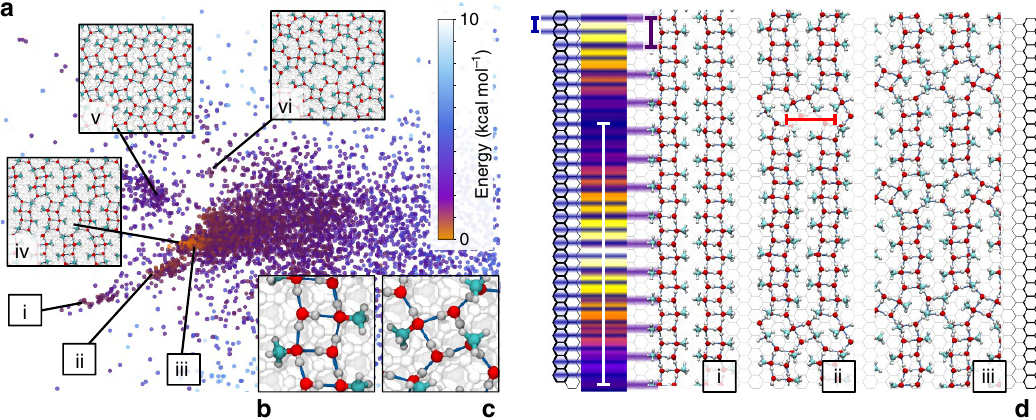
Figure 3 | Catalogue of stable 2D structures for a 1:1 MeOH:water monolayer. Each structure was obtained by replica-exchange simulations ( a ). Each dot represents a particular structure whose stability (energy) is colour-coded. Six representative structures (i–vi) are presented (in inset ( a ) and in ( d )). Most structures share a recurring water-MeOH ‘square’ motif ( b ) forming ribbons. The same motif exists with a corner-sharing arrangement ( c ), inducing defects in the ribbon structure ( d ) that relieve the mismatch between the periodicity of the ribbon (5.20Å, purple bar) and that of HOPG underneath (2.46Å, blue bar). This mismatch induces Moire´ patterns with a lengthscale of B 45Å (white bar). The yellow-purple ribbon in ( d ) illustrates the degree of mismatch using the colour scale of AFM topographic images. The distance between adjacent ribbons is typically 8.2Å (red